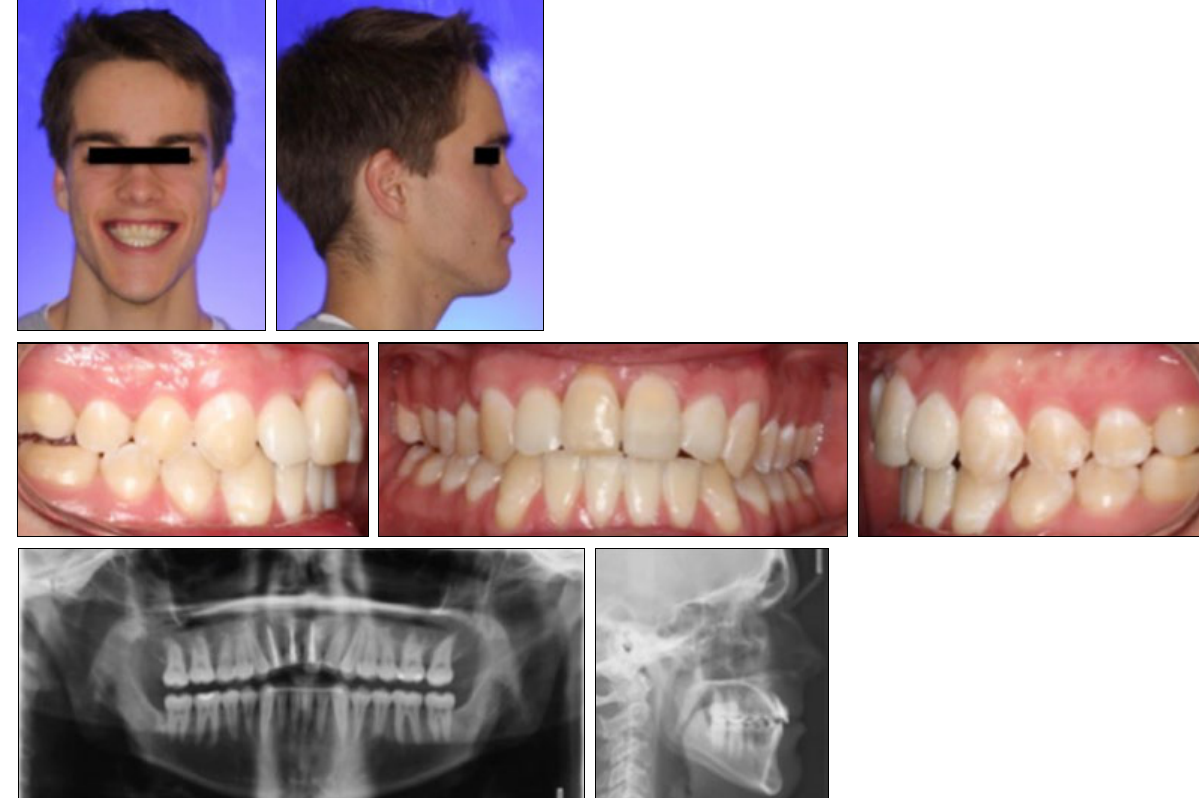
Figure 8. Deband photos, OPG and lateral cephalogram